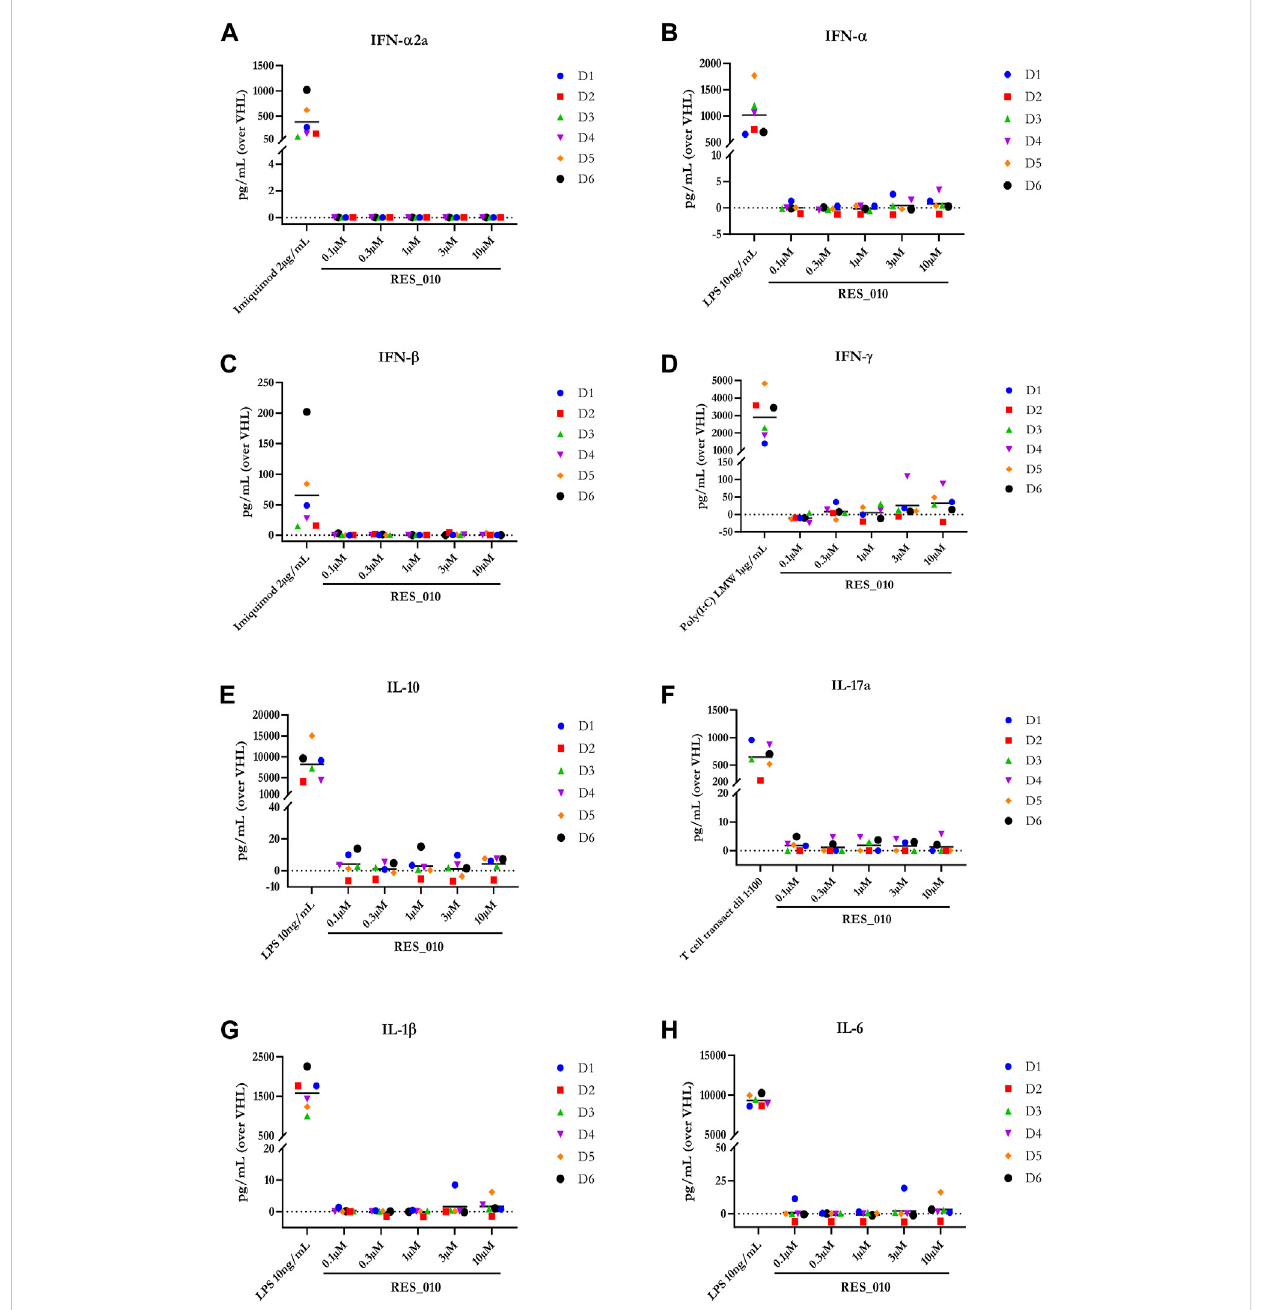
FIGURE 1 CytokinelevelsaftertreatmentofhumanPBMCswithRES-010.Datafromindividualdonorsarerepresentedasmedianoftechnicaltriplicates,while the solid line represents the median of the entire group. Each graph represents data for a single cytokine after stimulus with positive control or with RES- 010 at different concentrations. The analyzed cytokiens are; (A) IFN α -2a, (B) IFN- α , (C) IFN- β , (D) IFN- γ , (E) IL-10, (F) IL-17 α , (G) IL1- β , and (H) IL-6.